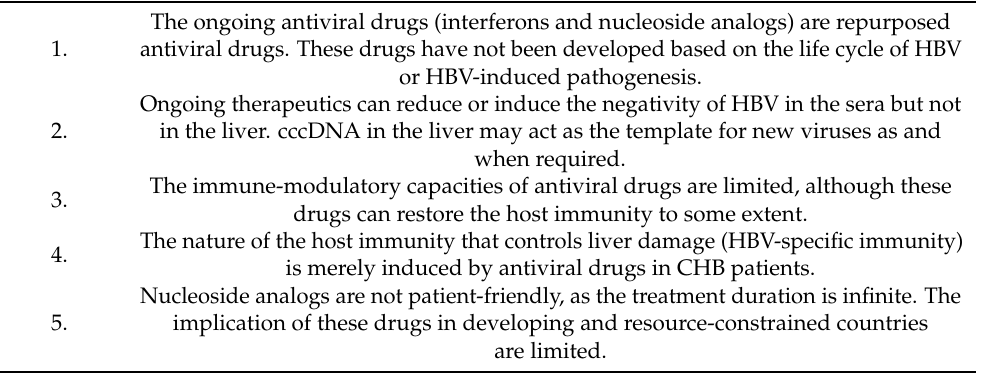
Table 1. Limitation of ongoing antiviral therapeutics (interferons and nucleoside analogs) for the treatment of chronic hepatitis